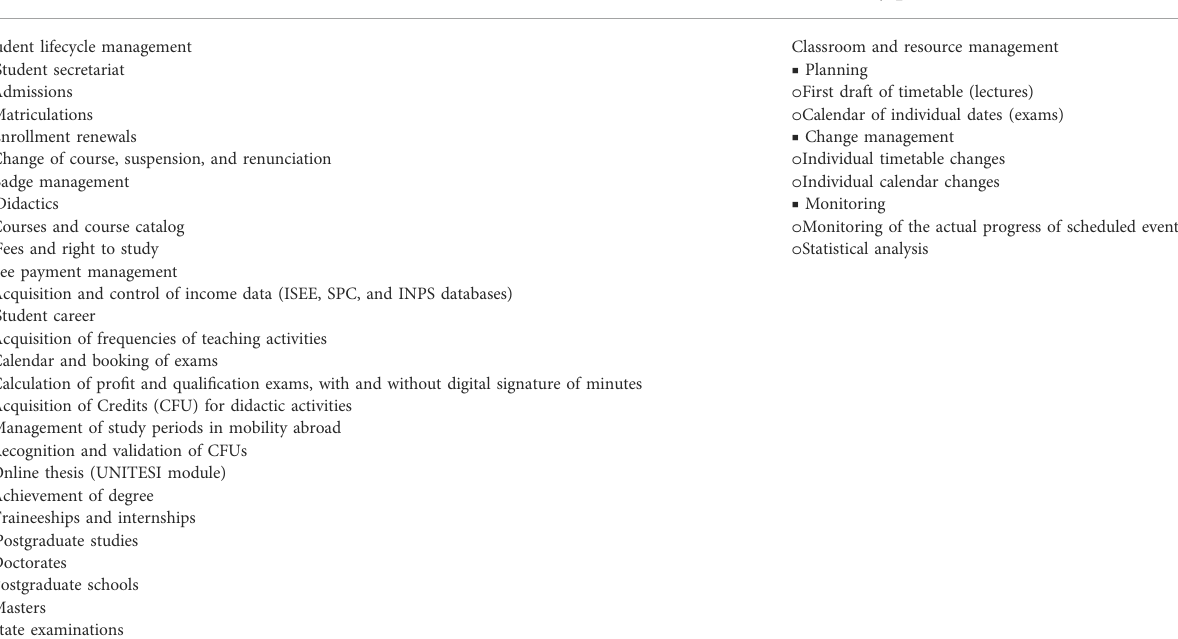
TABLE 3 Functionalities provided by Cineca tools. Esse3